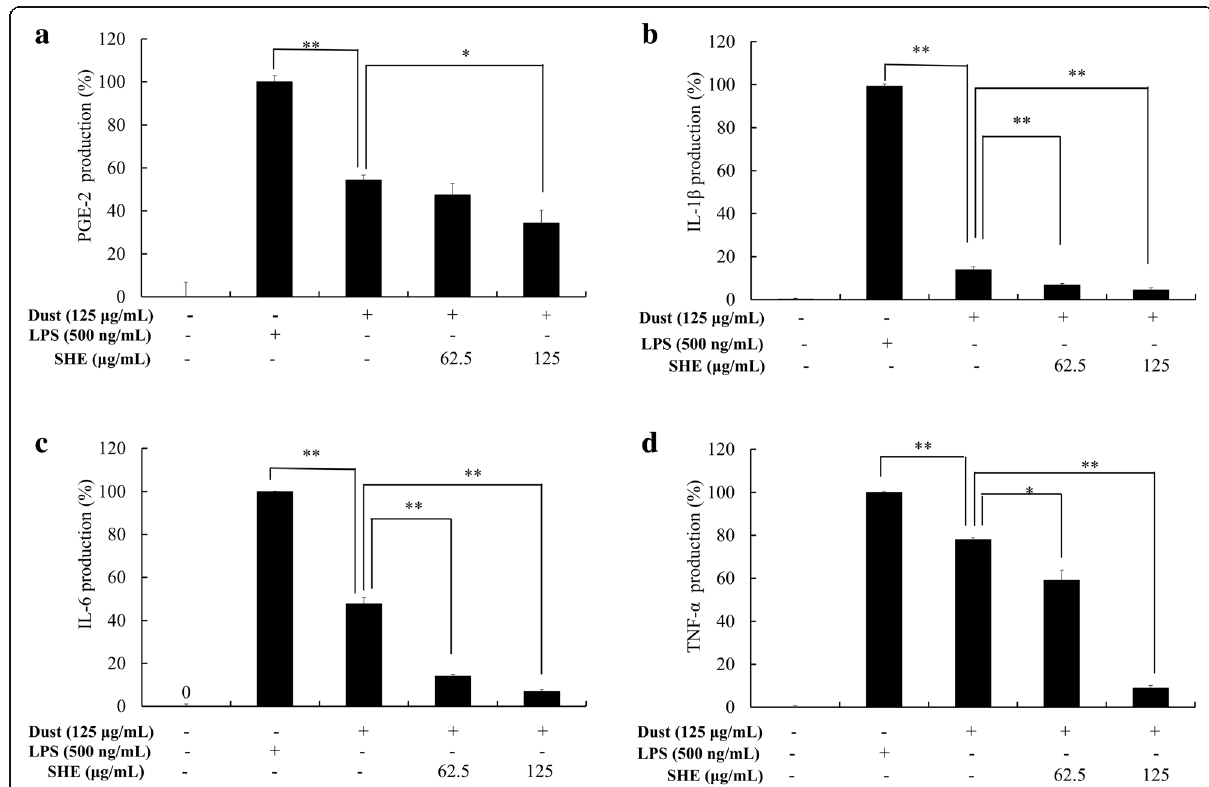
Fig. 3 Inhibitory effect of SHE on the PGE2 and pro-inflammatory cytokines (IL-1 β , IL-6, and TNF- α ) production in FD-induced RAW 264.7 cells determined using ELISA. Culture supernatants of RAW 264.7 cells after successive treatment with LPS or FD were used to quantify the inflammatory cytokines and PGE2. Triplicate experiments were used to evaluate the data, and the mean value is expressed as ± SD. t-test was used to calculate the level of significance. * = p < 0.05 and ** = p <